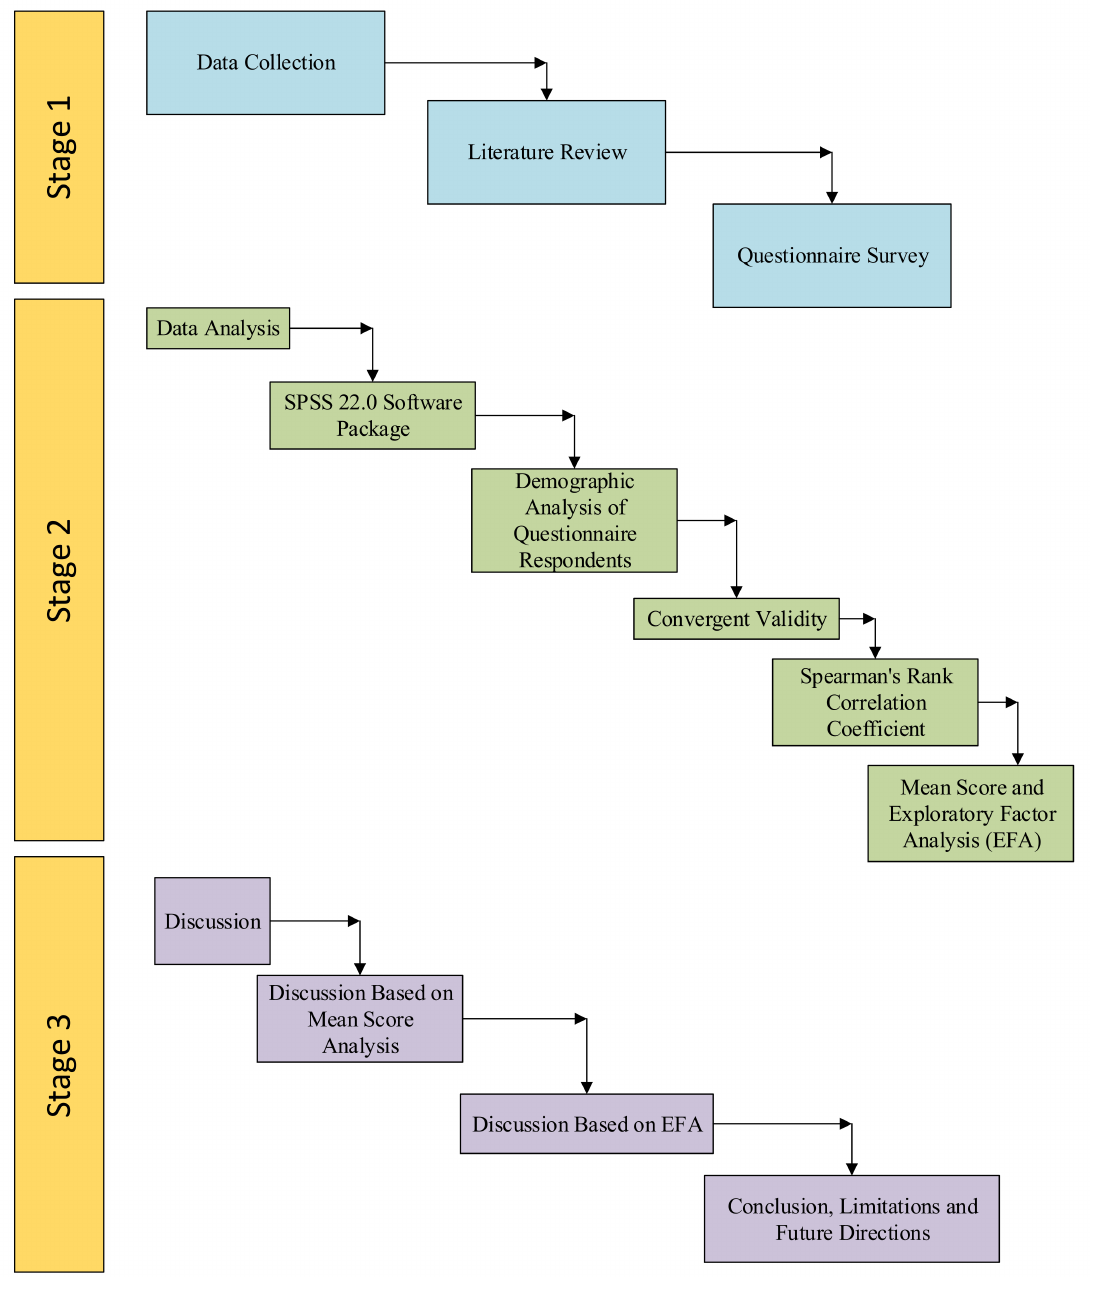
Figure 1. Research flowchart